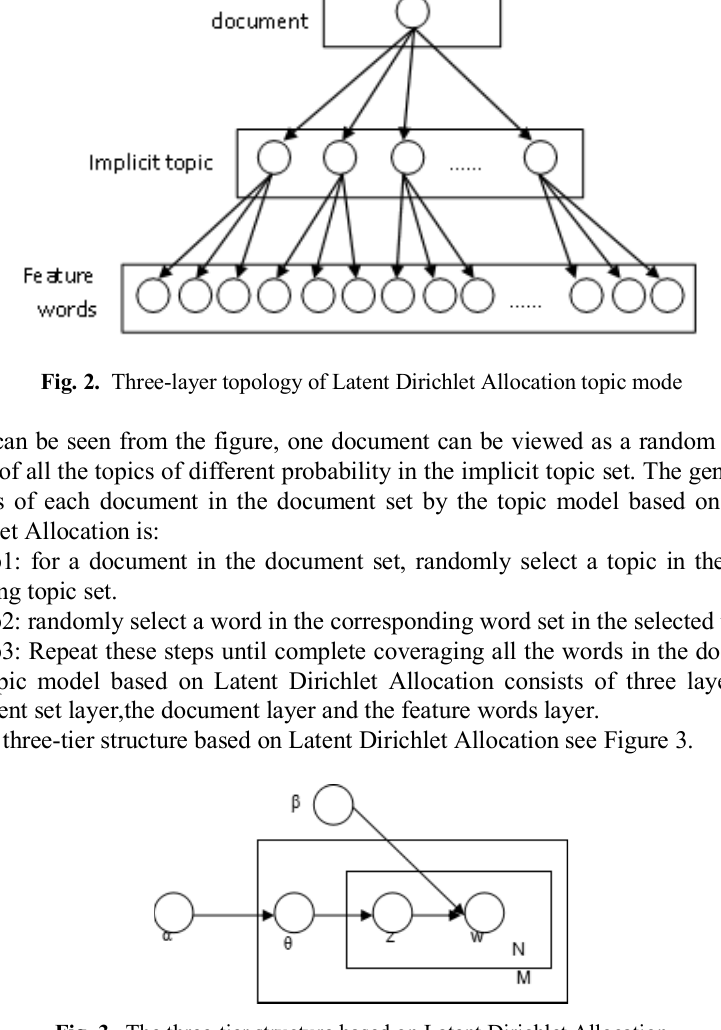
Fig. 3. The three-tier structure based on Latent Dirichlet